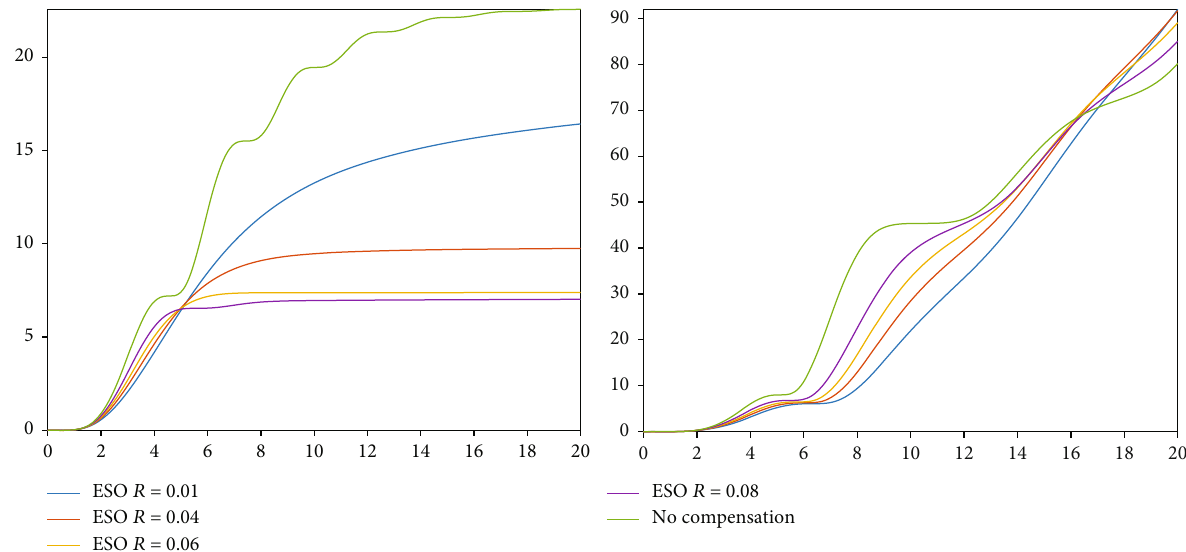
Figure 23: E ff ect of line-of-sight velocity extraction on dimensionless miss distance under step and wave disturbance.